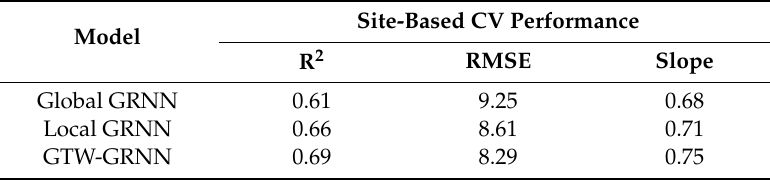
Table 3. Site-based CV performance of the global GRNN, local GRNN, and GTW-GRNN models.